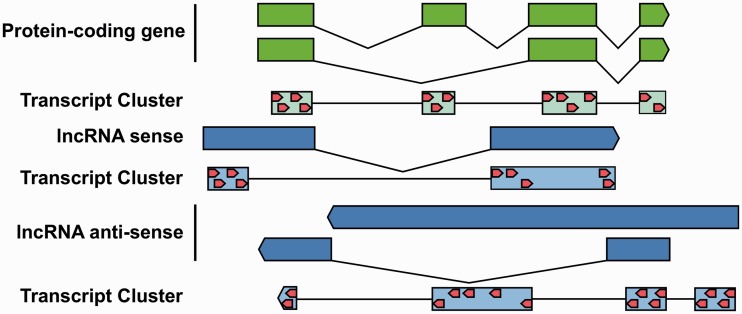
The Affymetrix annotation combines all isoforms of protein-coding genes (green) into a transcript cluster (light green). To measure the gene expression, all probes (red) of the transcript cluster are used. The exon expression can be measured by the probe set (light green boxes). We adopted this system for lncRNAs. Additional probes, which do not overlap with protein-coding genes, were used to define custom transcript cluster and probe sets. Overlapping lncRNAs on the same strand were combined to transcript cluster. Probe sets were defined to be contiguous regions not crossing exon boundaries. This allows for measuring gene and exon expressions, which are analogous to those of the Affymetrix annotation.